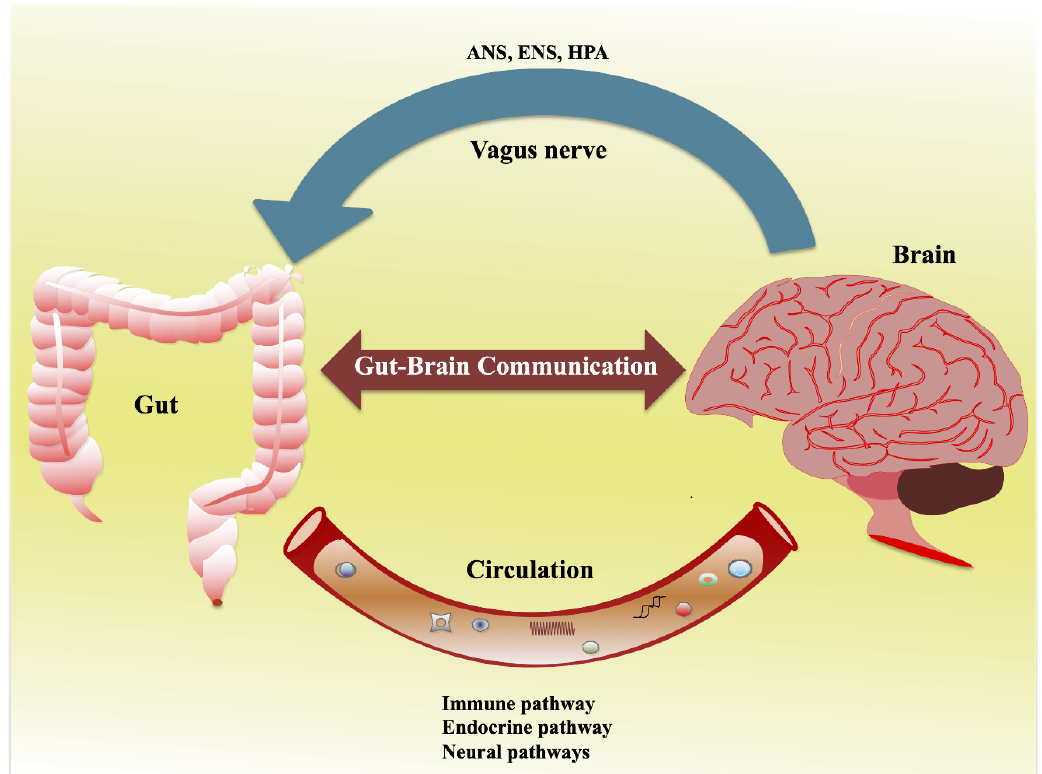
Figure 1. Schematic diagram showing the communication between the gut and brain. This is a bidirectional relationship that is strongly influenced by multiple pathways, including the autonomic nervous system (ANS), enteric nervous system (ENS), hypothalamic – pituitary – adrenal (HPA), immune pathways, endocrine pathways, and neural pathways.